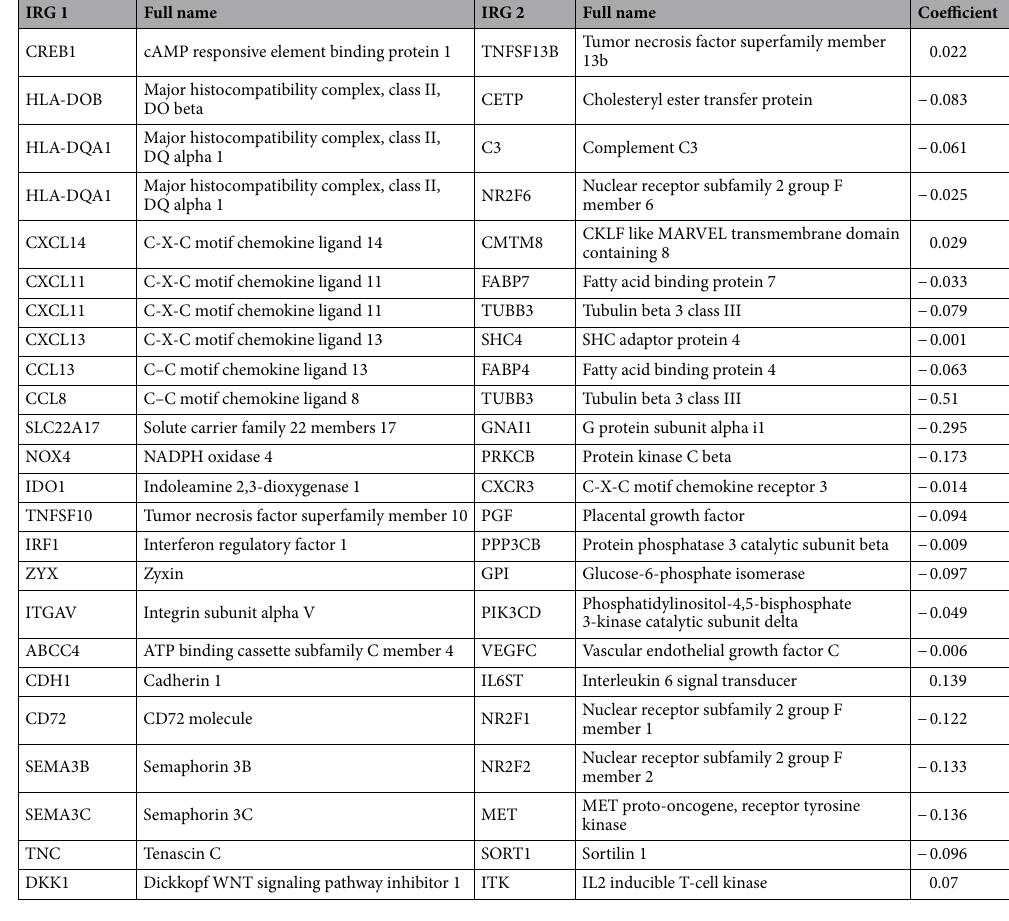
Table 2. The information of 24 IRGPs in the selected model. Abbreviation: IRGPs immune related gene pairs, IRG1 immune related gene 1, IRG2 immune related gene 2.